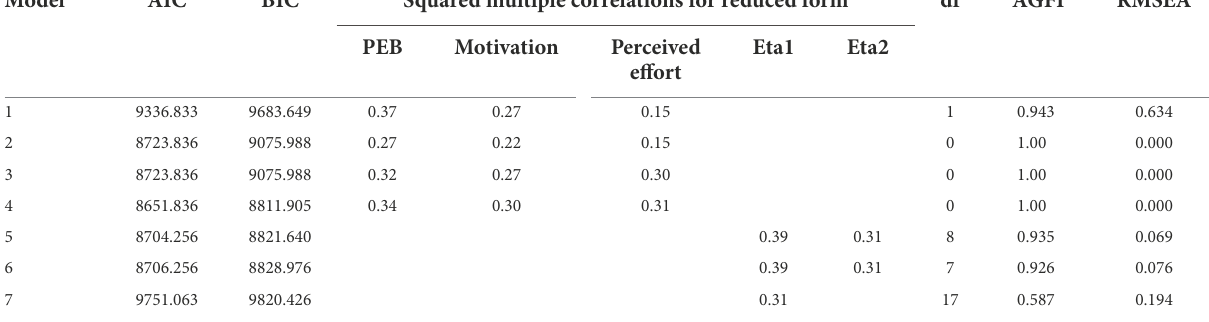
TABLE 3 AIC, BIC, squared multiple correlations, df, AGFI and RMSEA values for the seven models. Model AIC